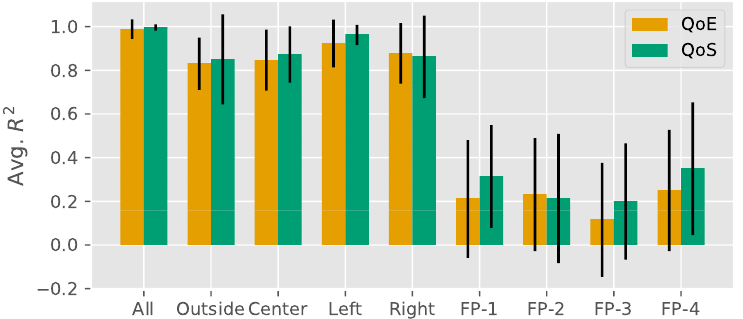
Figure 5. R 2 scores for the regular image (AR) condition averages and standard deviations for subject ratings (QoE) and impairment level (QoS) prediction performance analysis of individual